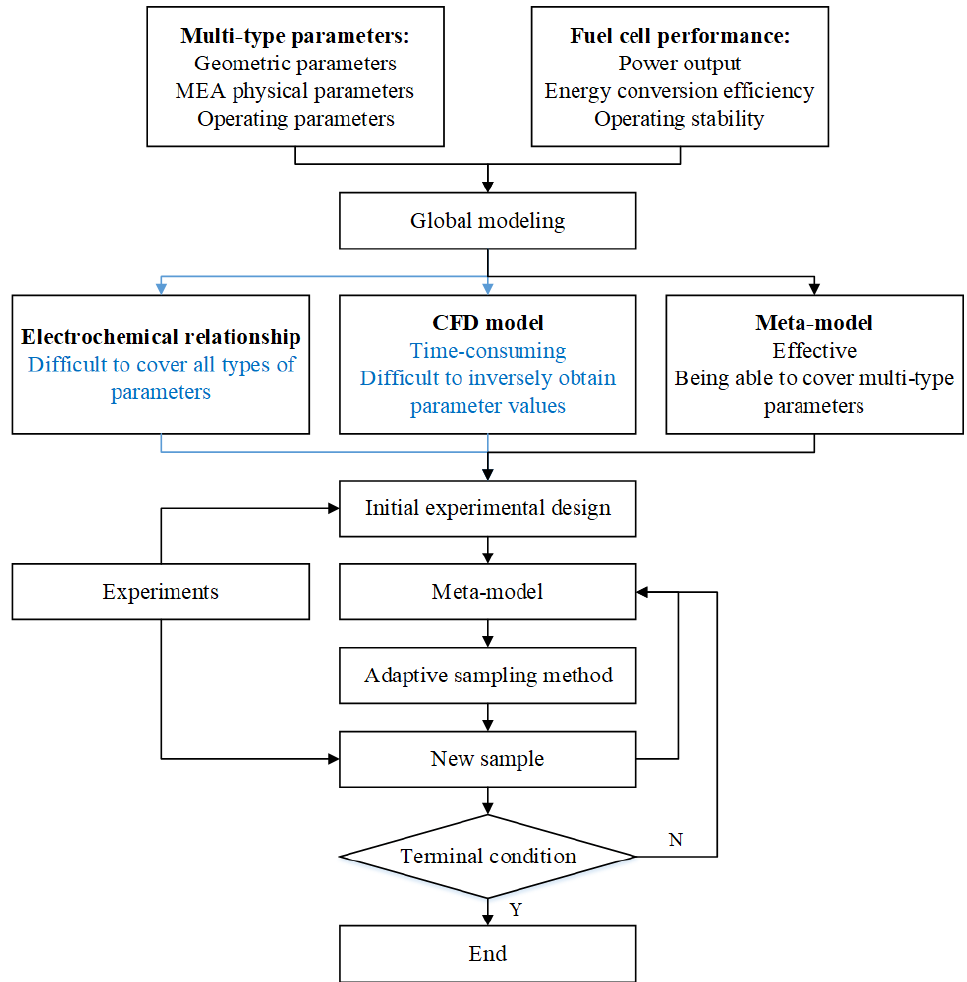
Figure 2. Schematic of global modeling process.